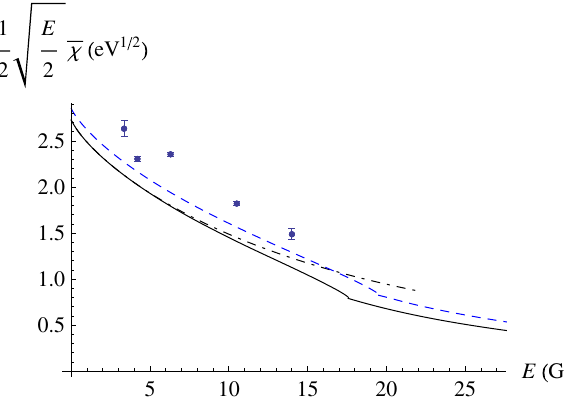
FIG. 8. Energy dependence of the mean VR angle for neg- atively charged particles in silicon crystal in orientation (111) at R ¼ 15 cm. Points, experimental data [10]. Curves: the same as in Fig. 6. A break in the curves around E ¼ 18 GeV occurs because the minor potential bump rises above the major barrier due to the large tilt, making the potential double-well instead of single-well. At that, one has to switch from Eq. (12) to Eq. (13).